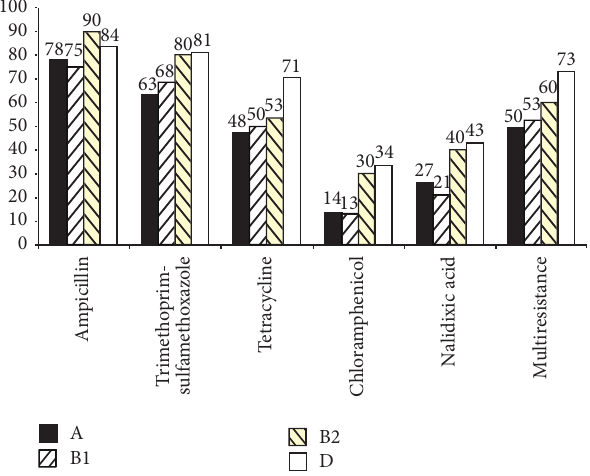
Figure 2: Percentages of multiresistance (resistance to 3 or more different antibiotics families) and antibiotic resistance among the four phylogenetic groups A ( 𝑛 = 147 ), B1 ( 𝑛 = 76 ), B2 ( 𝑛 = 30 ), and D ( 𝑛 = 116